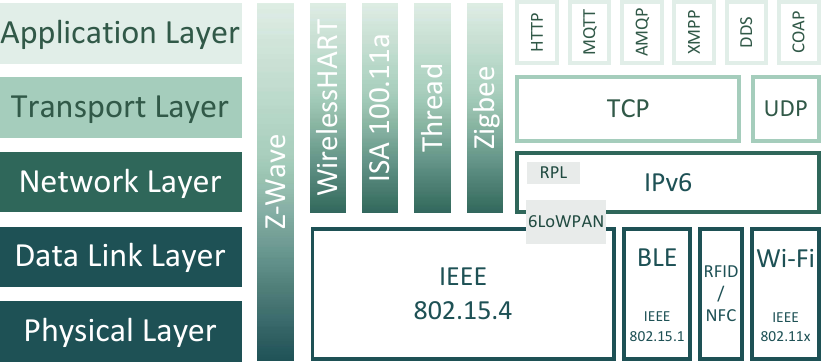
Figure 1. Connectivity heterogeneity on the IoT space (adapted from